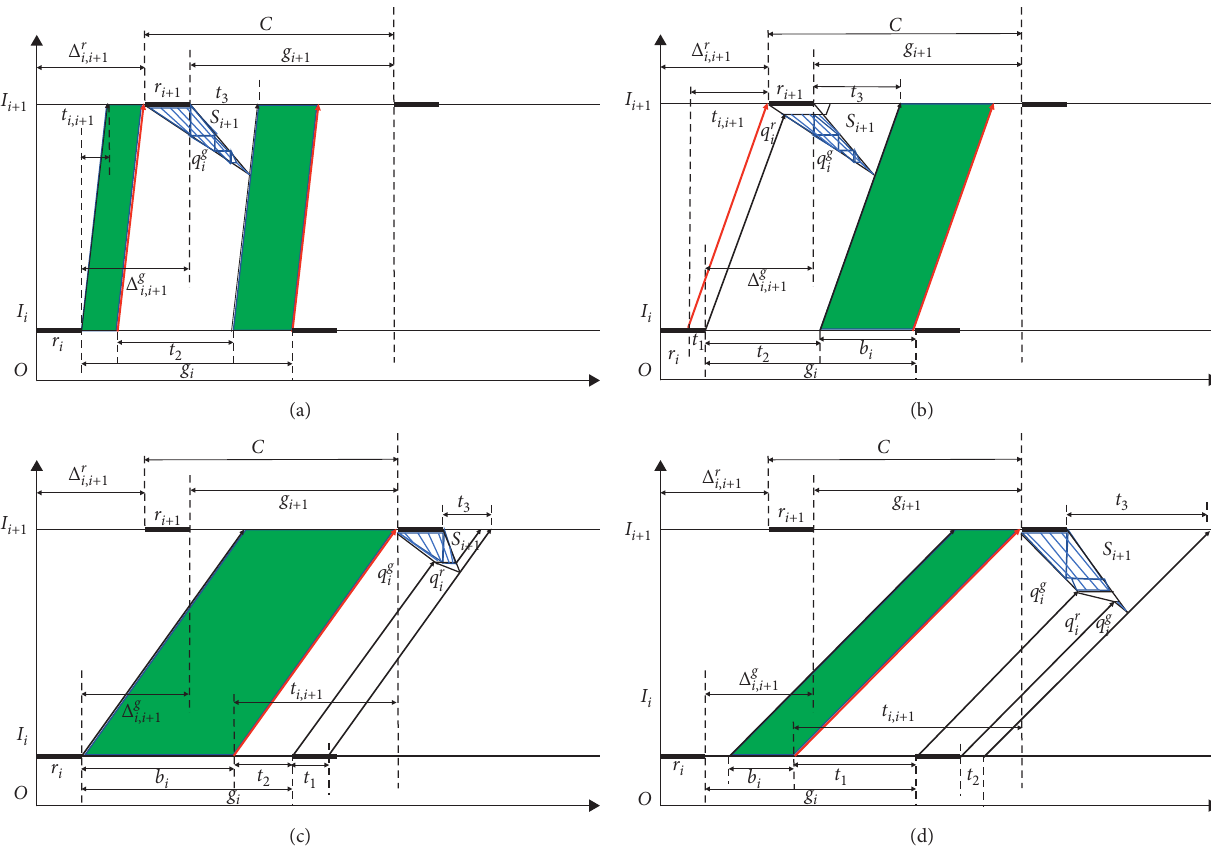
Figure 2: Four categories of interlaced spatiotemporal